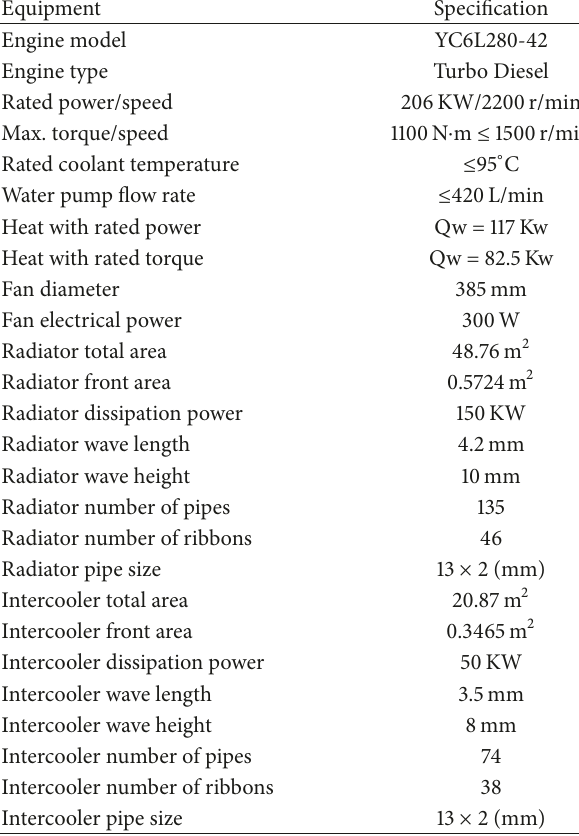
Table 2: Specifications of the equipment for